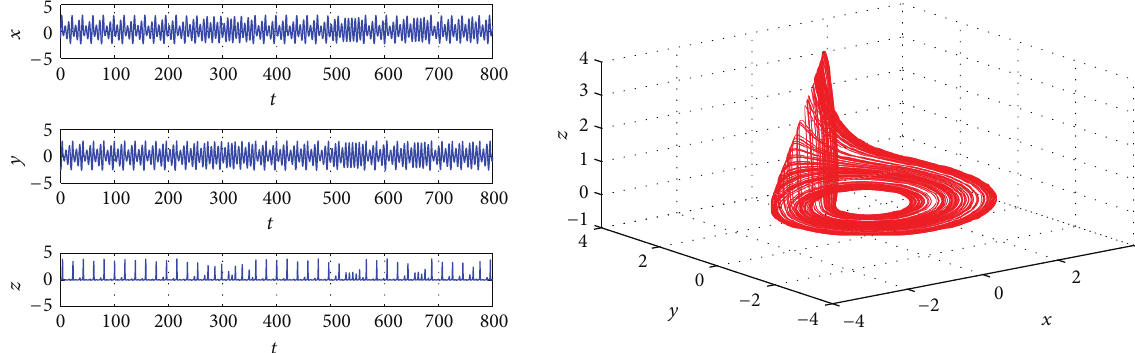
Figure 1: The trajectories and phase graphs of system (1) with 𝑎 = 0.2 and 𝑏 = 0.02